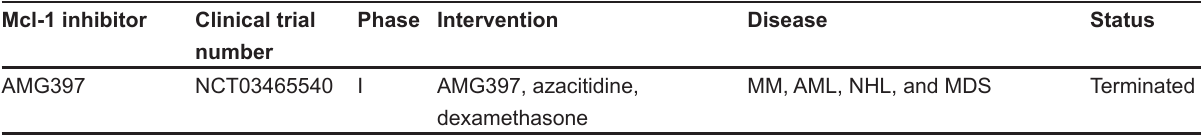
Allosteric Mcl-1